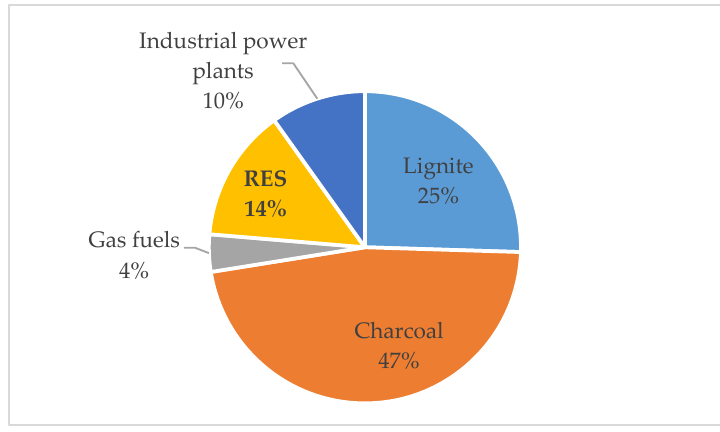
Figure 1. Share of energy carriers in total energy production in Poland in 2019 [5].